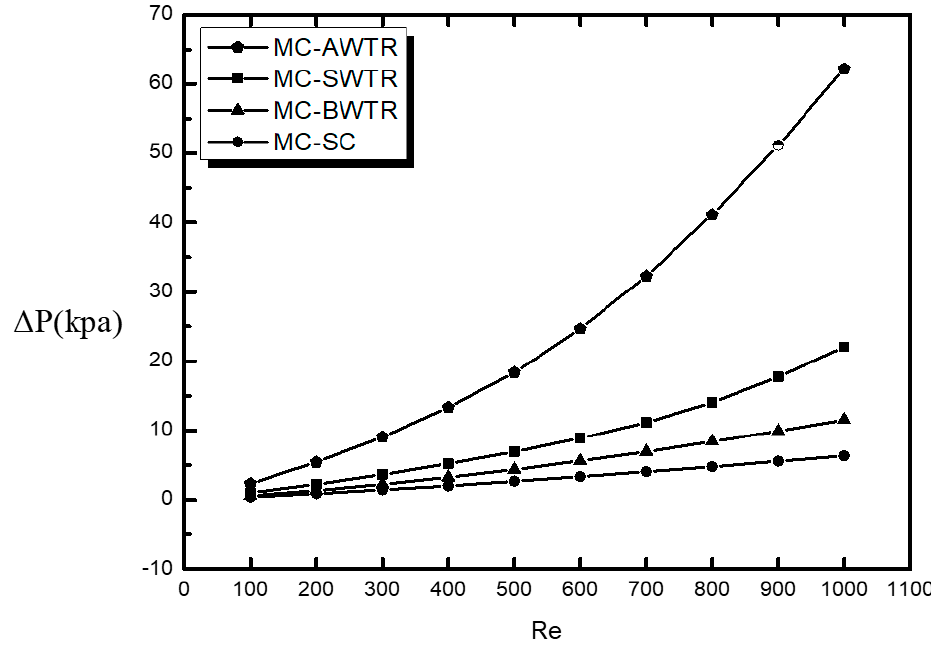
Figure 5. Comparison of pressure drop for various wall configurations